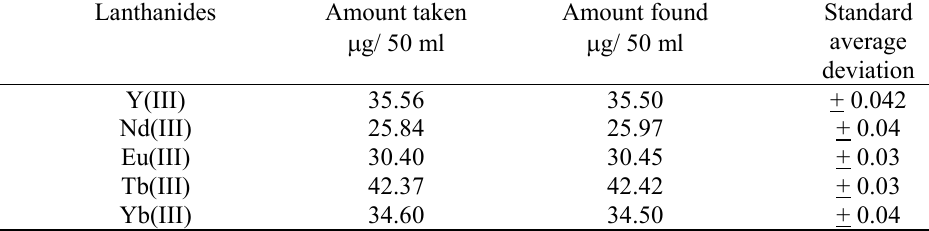
Table 6. Determination of Individual Metal Ion. Lanthanides Amount taken